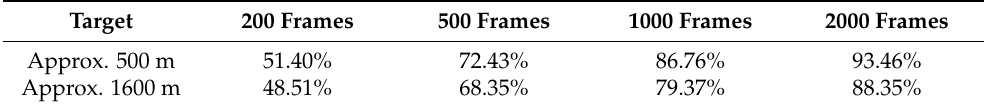
Table 2. Proportions of valid data relative to reference data obtained from 20,000